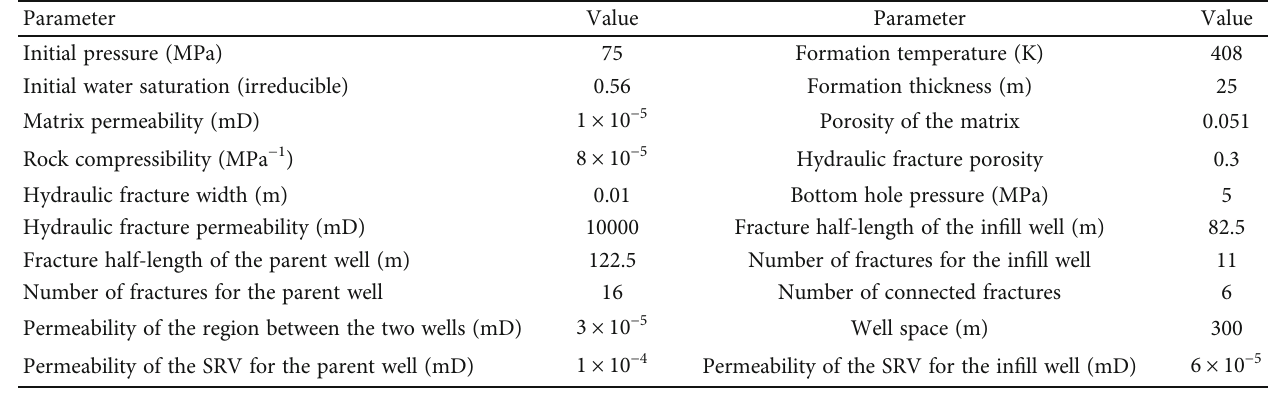
Table 3: Parameters for the validation case.